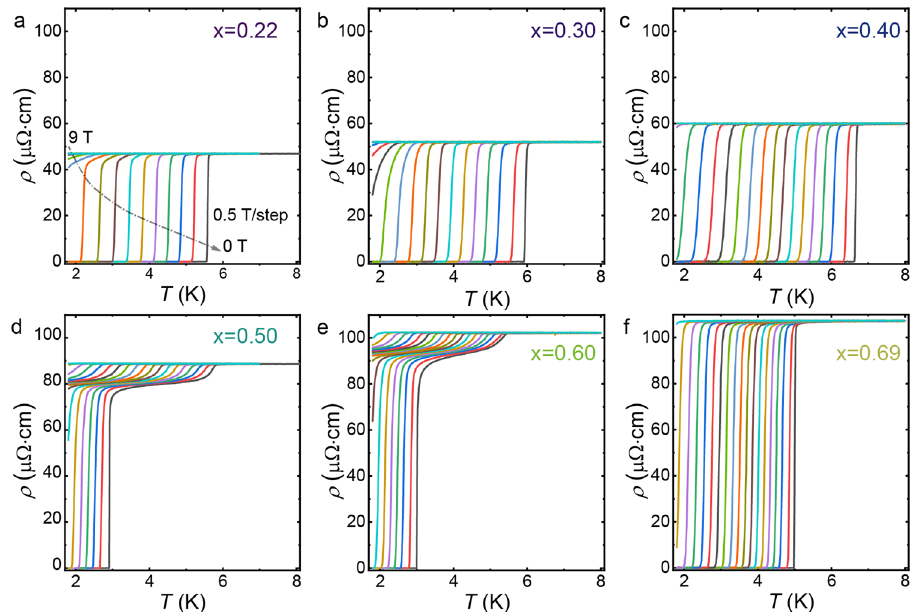
Fig. 4 Magnetotransport properties of (TaNb) 1 − x (ZrHfTi) x fi lms. a – f The temperature dependence of the resistivity in magnetic fi elds from 0 to 9 T for x = 0.22, 0.30, 0.40, 0.50, 0.60, and 0.69,